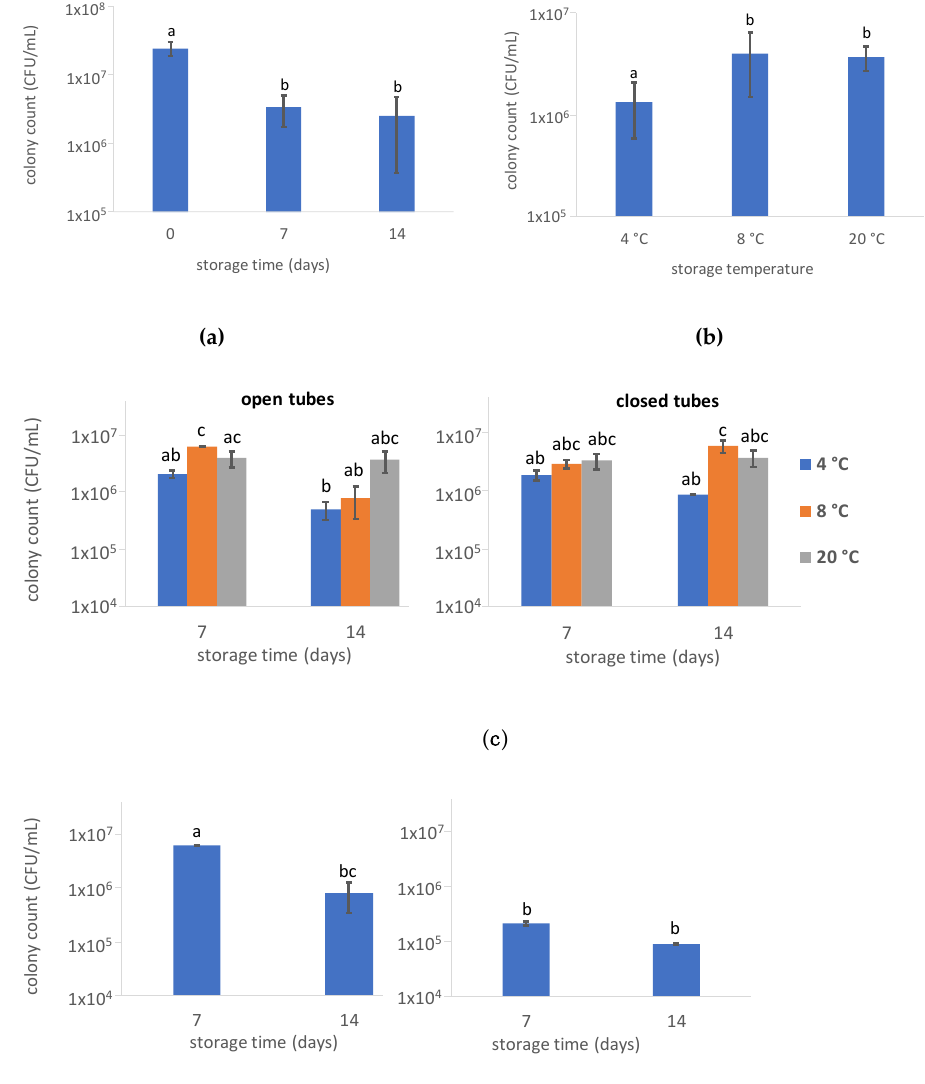
Figure 1. Total microbial load—storage experiment 1. ( a ) Average colony count after 0, 7 and 14 days of storage in algae samples without added acetic acid. ( b ) E ff ect of storage temperature for algae without acetic acid addition and stored for 7 or 14 days. ( c ) Average colony count of algae without acetic acid addition. ( d ) E ff ect of acetic acid addition for algae stored at 8 ◦ C in open tubes. Lowercase letters (a,b,c) denote significant di ff erences; values within one figure that are not labelled by the same letter are significantly different. Error bars represent standard deviations. CFU: colony forming units.